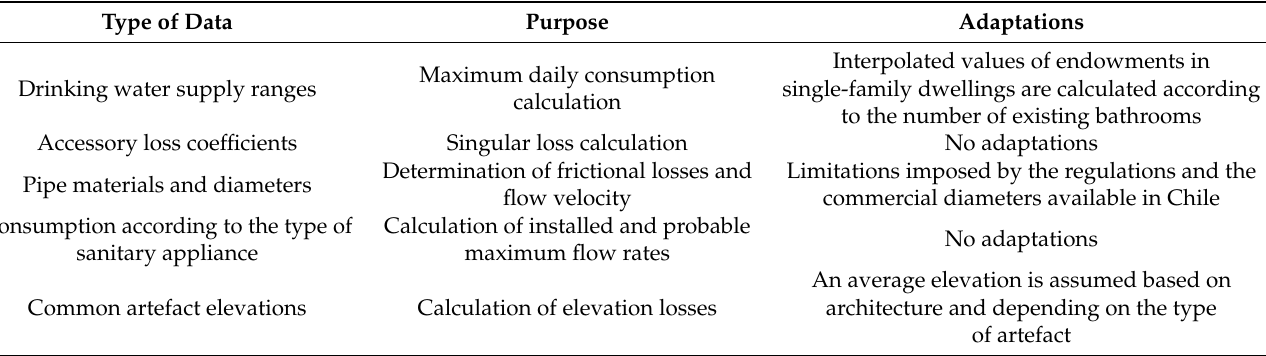
Table 5. Contents of the database for the calculation of sanitary plumbing water